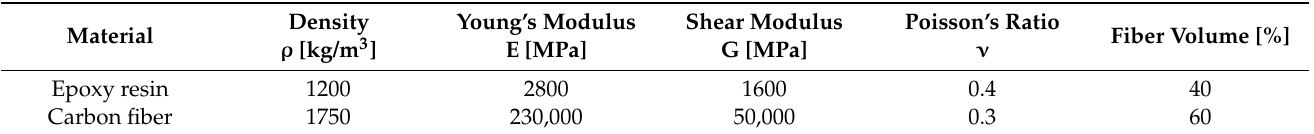
Table 5. Composite properties.